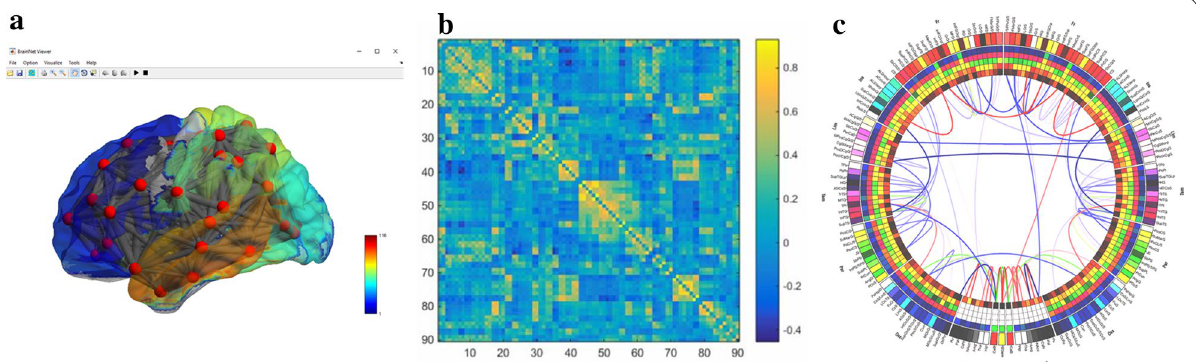
Fig. 7 Examples of the three most common direct connectivity measure visualisation techniques: a node–link diagram which is overlaid on a 3D anatomy (created in BrainNet Viewer [77]). This minimises the need for mental reconstruction of the anatomy, but can increase clutter and imply direct connections; b matrix visualisation where pairwise coactivation values are displayed on the grid. This requires more mental reconstruction of the anatomy, but it is better for subject comparison and is clutter free; c radial connectivity diagram (created in the pipeline by Irimia et al. [78]). This implies anatomical location through node ordering, while also not implying direct connections and minimising visual